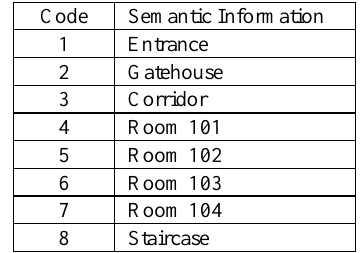
Table 1 Location information of experiment building Table 2 enumerates the relation of topology of indoor